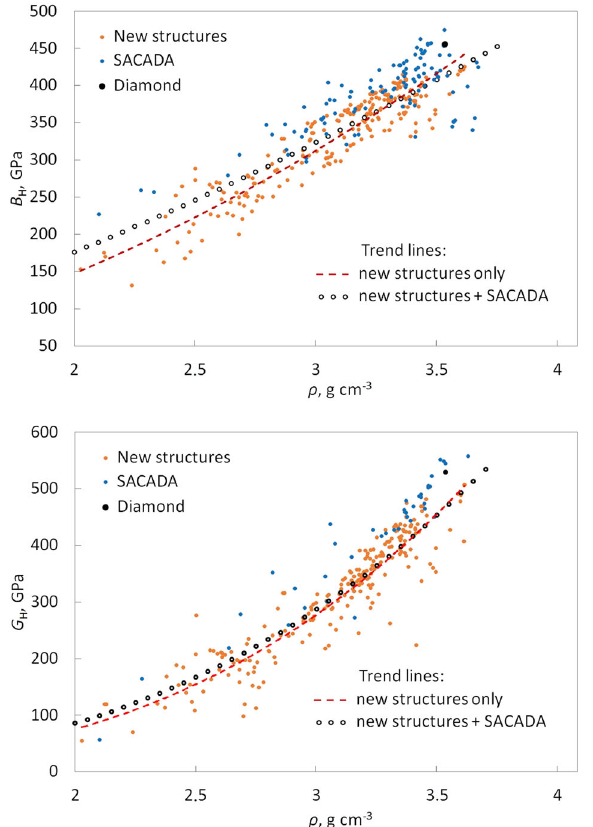
Fig. 2 Dependences B H = f ( ρ ) and G H = f ( ρ ). The dependences of the bulk modulus B H ( a ) and the shear modulus G H ( b ) on the density ρ for the 269 four-coordinated carbon allotropes. Two trend lines show the dependences for the data from this work ( ‘ new structures only ’ ; B H = 40.661 ρ 1.86 with R 2 = 0.86 and G H = 8.136 ρ 3.21 with R 2 = 0.84) and the data merged with the information from the SACADA database ( B H = 62.382 ρ 1.50 with R 2 = 0.72 and G H = 11.034 ρ 2.97 with R 2 = 0.80).